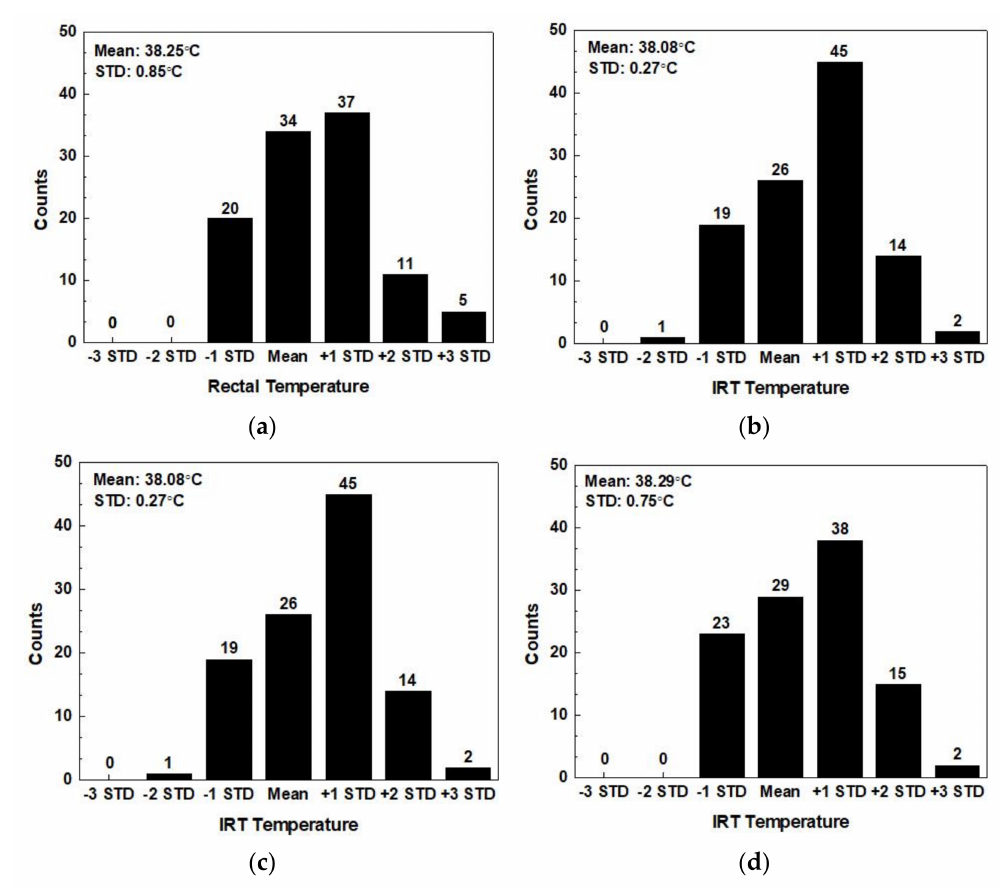
Figure 13. Measurement for IRT eye temperature and rectal temperature on 107 cattle. ( a ) Rectal temperature. ( b ) Original IRT temperature. ( c ) After IRT frame processing. ( d ) After